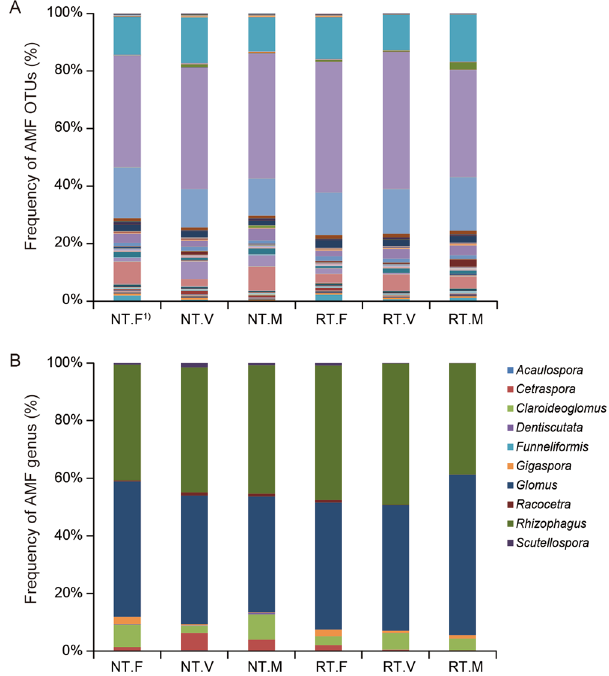
Figure 4. Relative abundance of operational taxonomic units (OTUs) and genus of arbuscular mycorrhizal fungi (AMF) in the maize roots at the eight fully emerged leaves stage. 1) RT: rotary tillage, NT: no tillage. F: fallow, M: brown mustard, V: hairy vetch. A = OTU-based abundance, B = genus-based abundance.